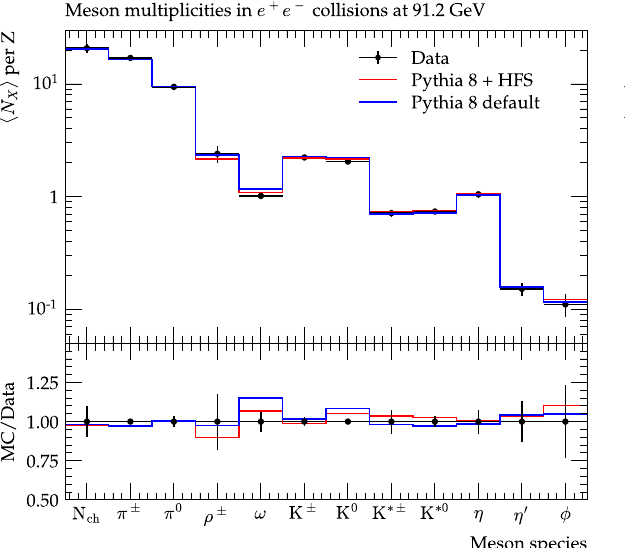
parameters (in red), as described in the text. Data are from various LEP experiments and SLD, with references in the text